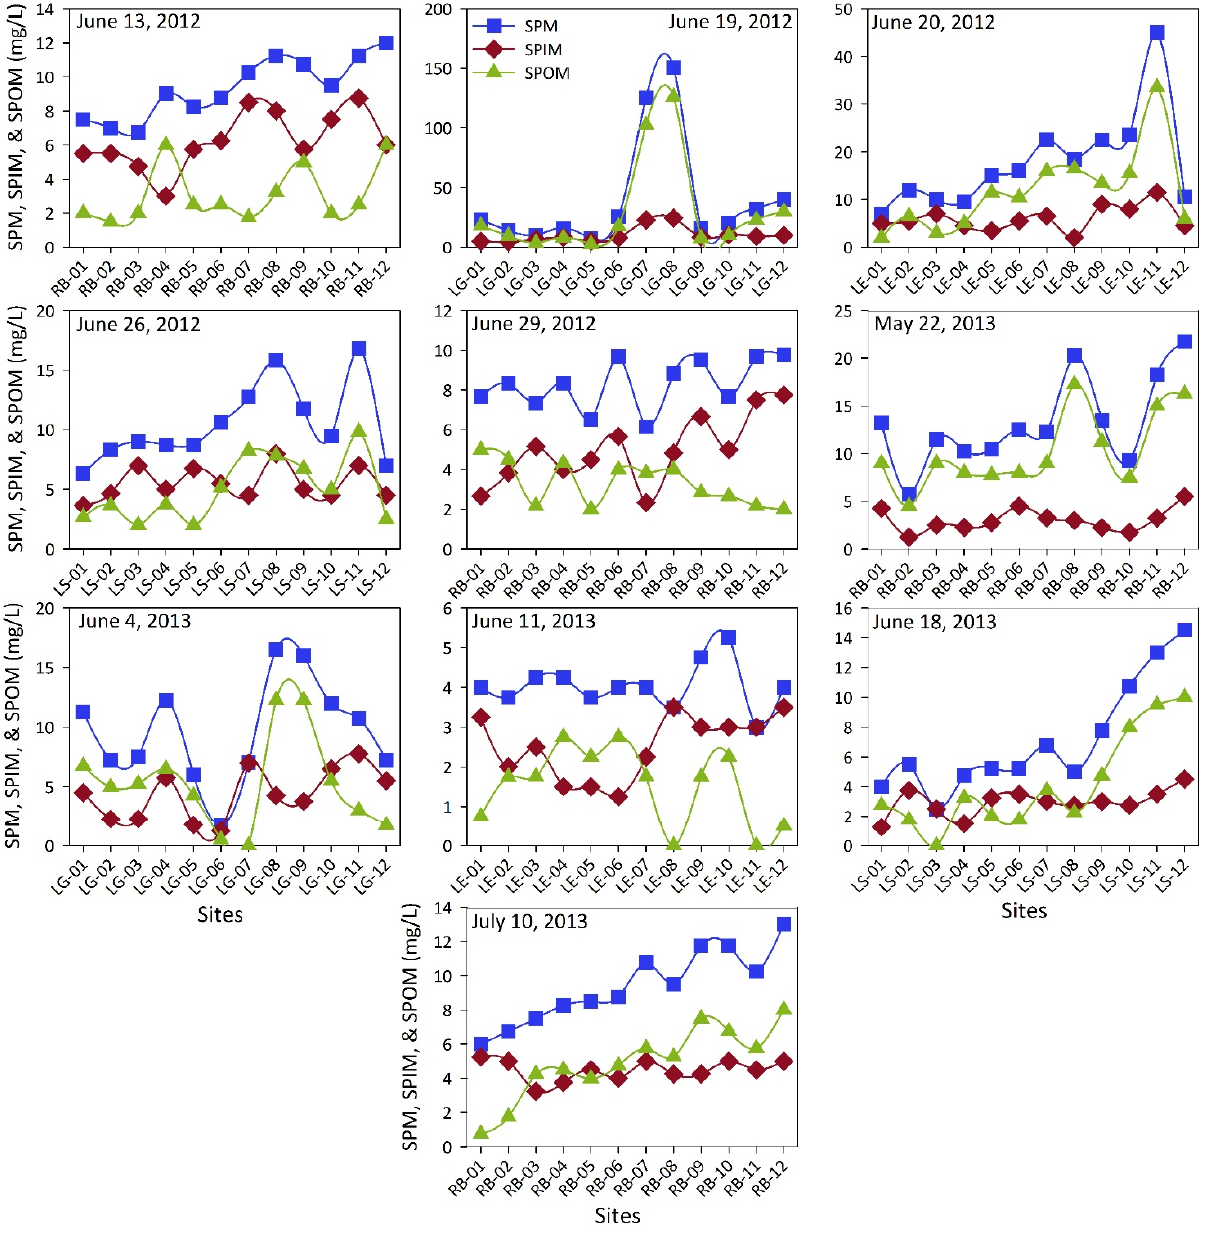
Figure 4. Suspended particulate matter (SPM), suspended inorganic particulate matter (SPIM), and suspended organic particulate matter (SPOM) concentrations at twelve sampling sites in each of the lakes (RB = Ross Barnett Reservoir, LG = Lake Grenada, LE = Lake Enid, and LS = Lake Sardis) with sampling dates